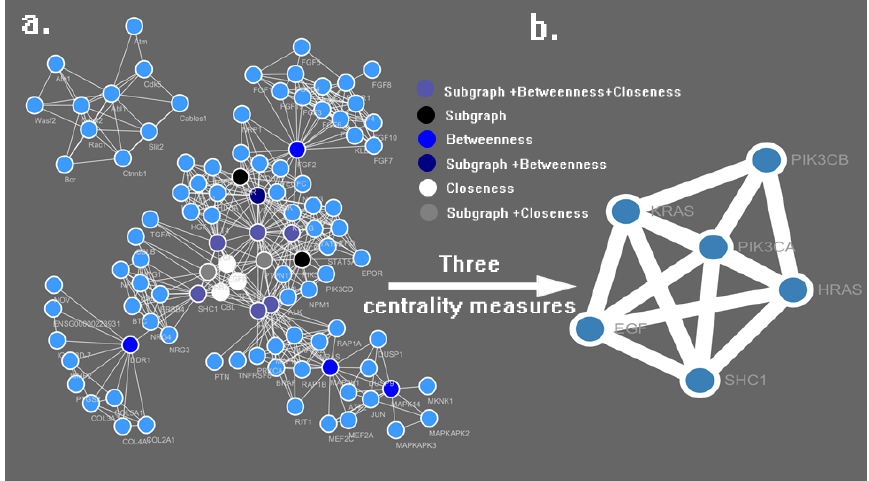
Figure 4. Network of cancer-related targets ( a ) and sub-network with essential targets ( b ), as generated by Cytoscape software and the CytoNCA plugin. Table 2. The 27 putative cancer-related proteins obtained from the PharmMapper platform.